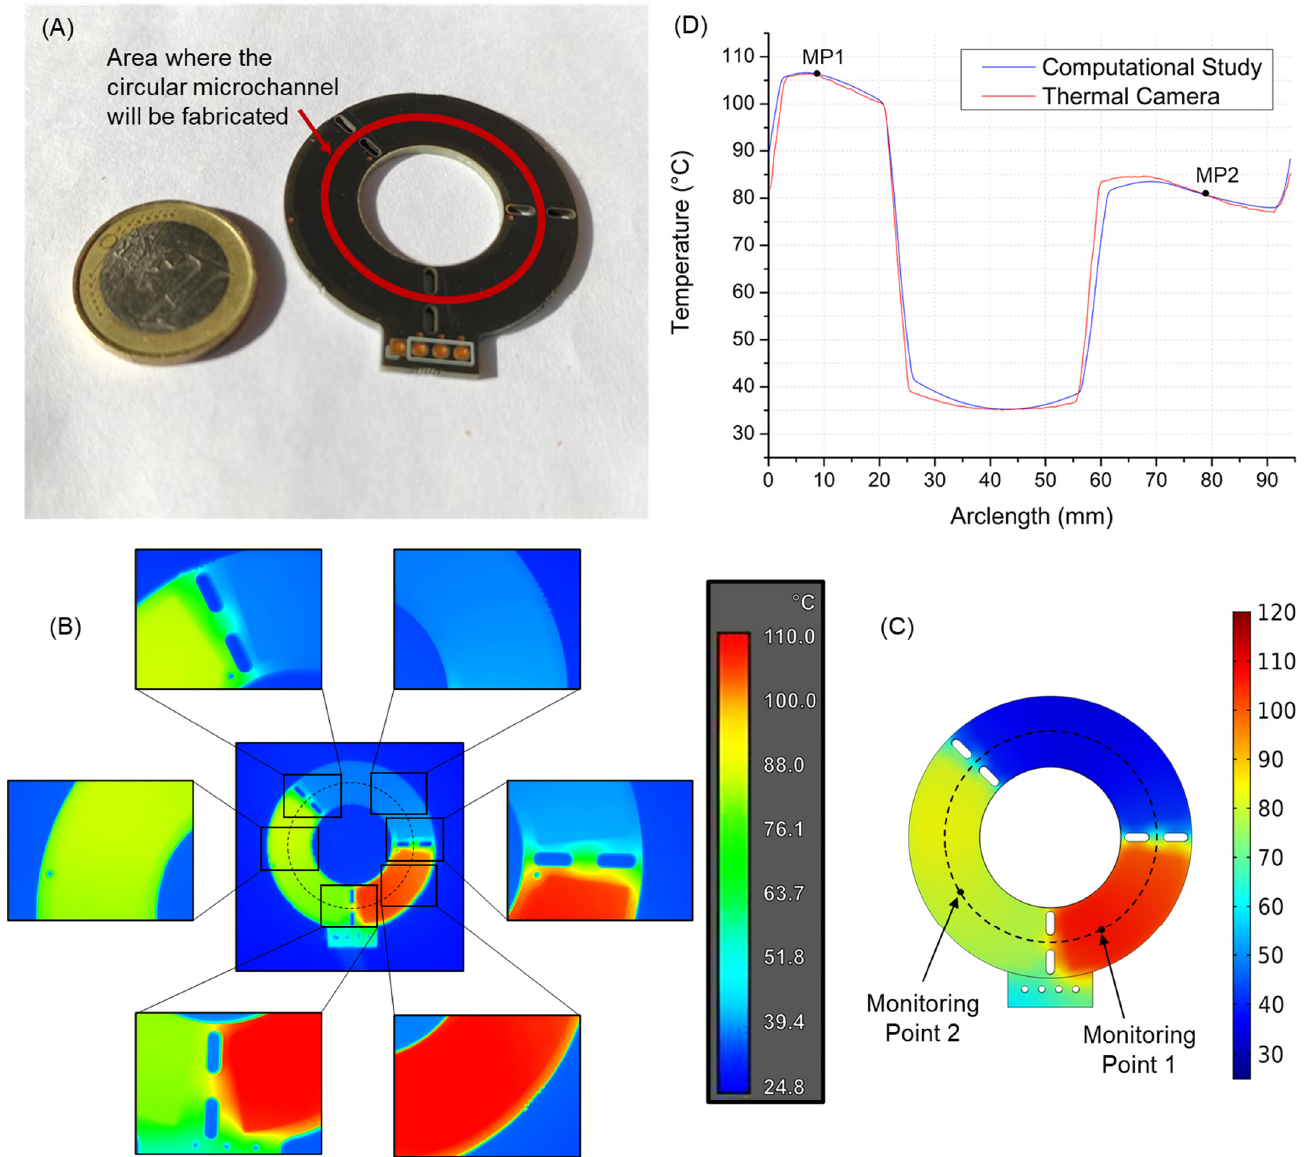
Figure 8. ( A ) PCB chip fabricated on the basis of the design in Figure 7. ( B ) Temperature distribution across the surface of the fabricated PCB chip, as measured with the use of a FLIR A300 thermal camera (image in the middle) and an external lens that provided magnification (side images). ( C ) Temperature distribution across the surface of the fabricated chip (third microreactor geometry) without microchannel or sample flow, as calculated in the computational study. The two monitoring points can be seen, in the denaturation and extension zones. ( D ) Comparison of the temperature profiles calculated in the computational study and measured on the fabricated chip surface, along a circle with radius of 15 mm (seen with dashed lines in Figure 8B,C). The two monitoring points can be seen in the denaturation and extension zones.